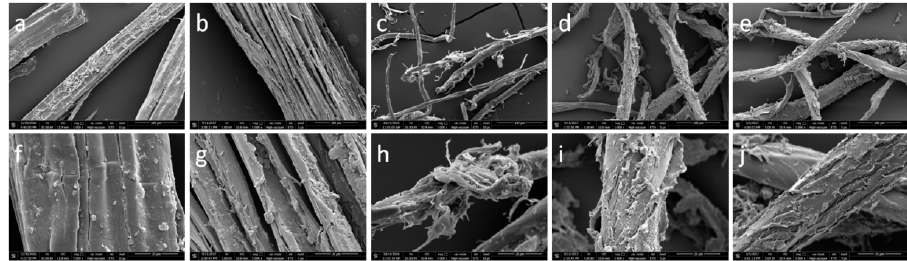
Figure 5. SEM images of jute ( a , f ), Jute laurate (R-JL, b , g ), pretreated jute (JSE, c , h ), JSE